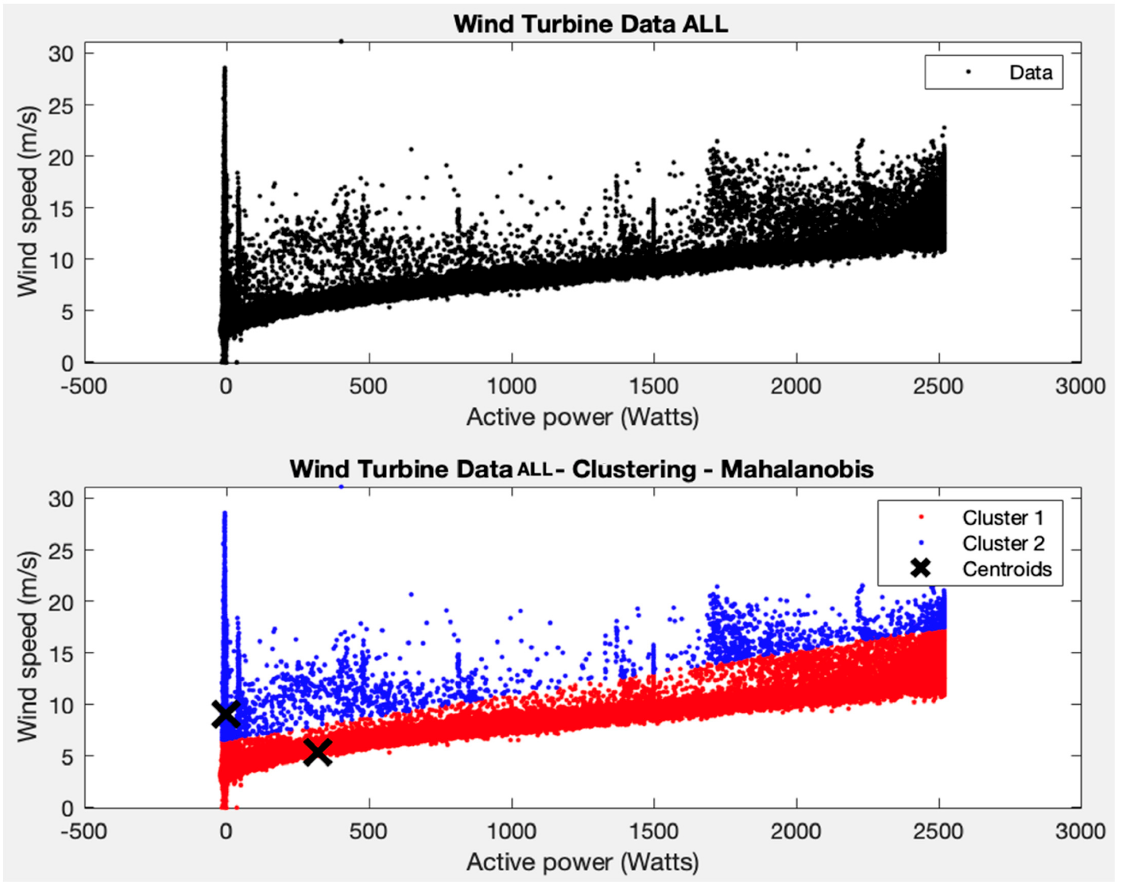
Figure 7. Test 5 results.